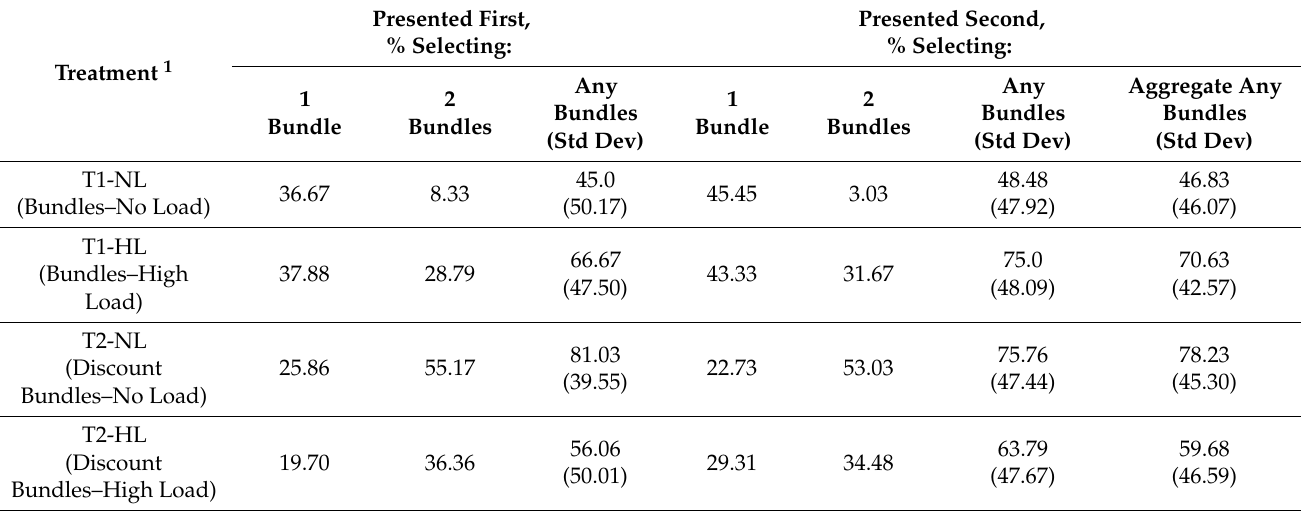
Table 4. Percentage of Consumers Selecting Food Bundles, by presentation order and